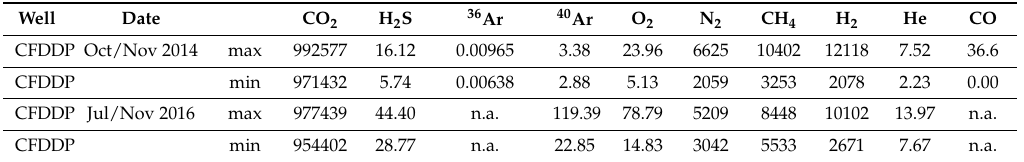
Table 1. Main gas concentrations measured in the CFDDP pilot hole before the fiber installation and after the period of DTS measurements shown in the